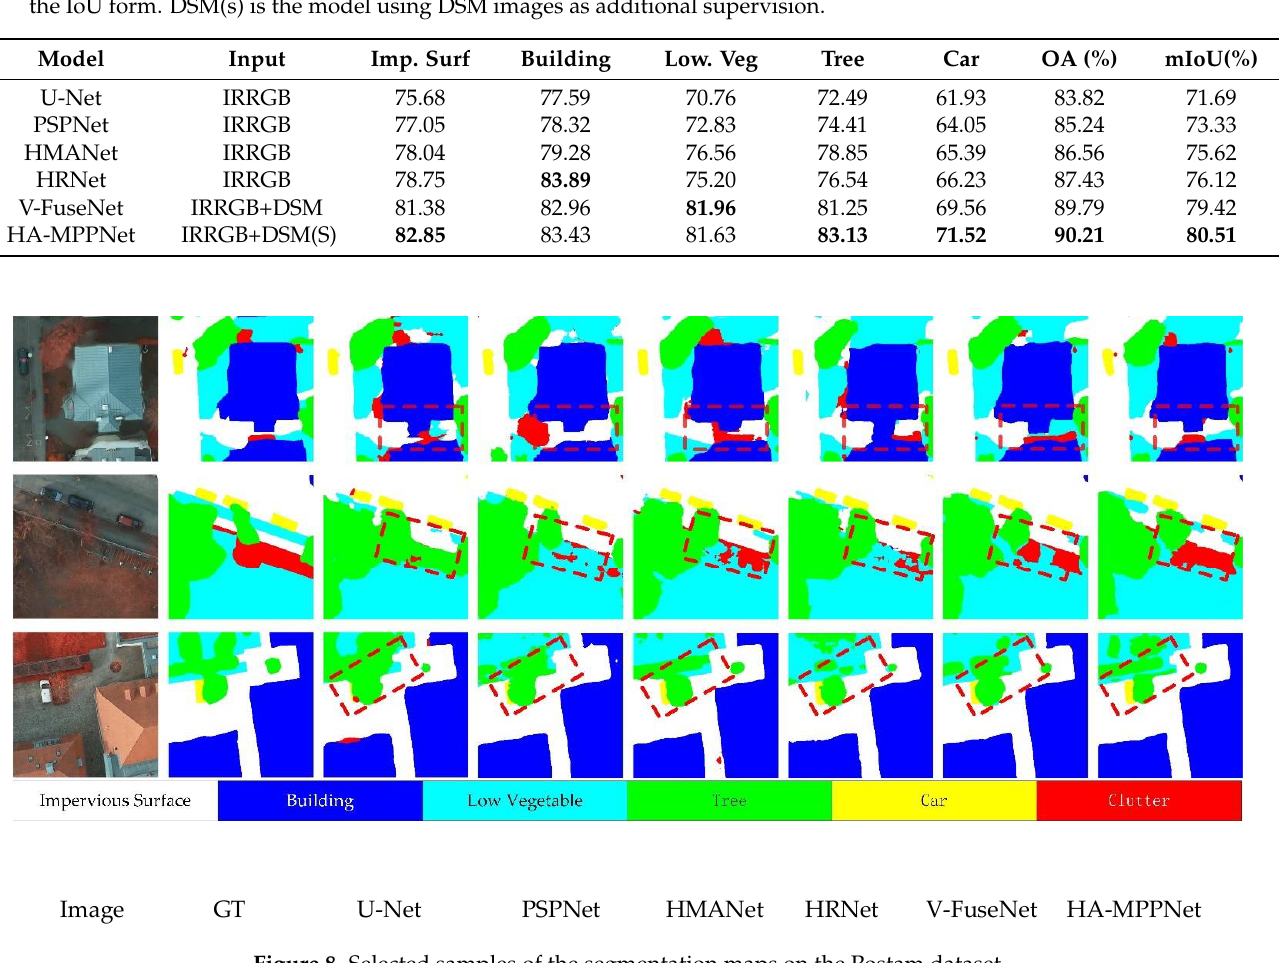
Table 2. Comparisons with state-of-the-art methods on the Postam dataset. The accuracy of each category is presented in the IoU form. DSM(s) is the model using DSM images as additional supervision.